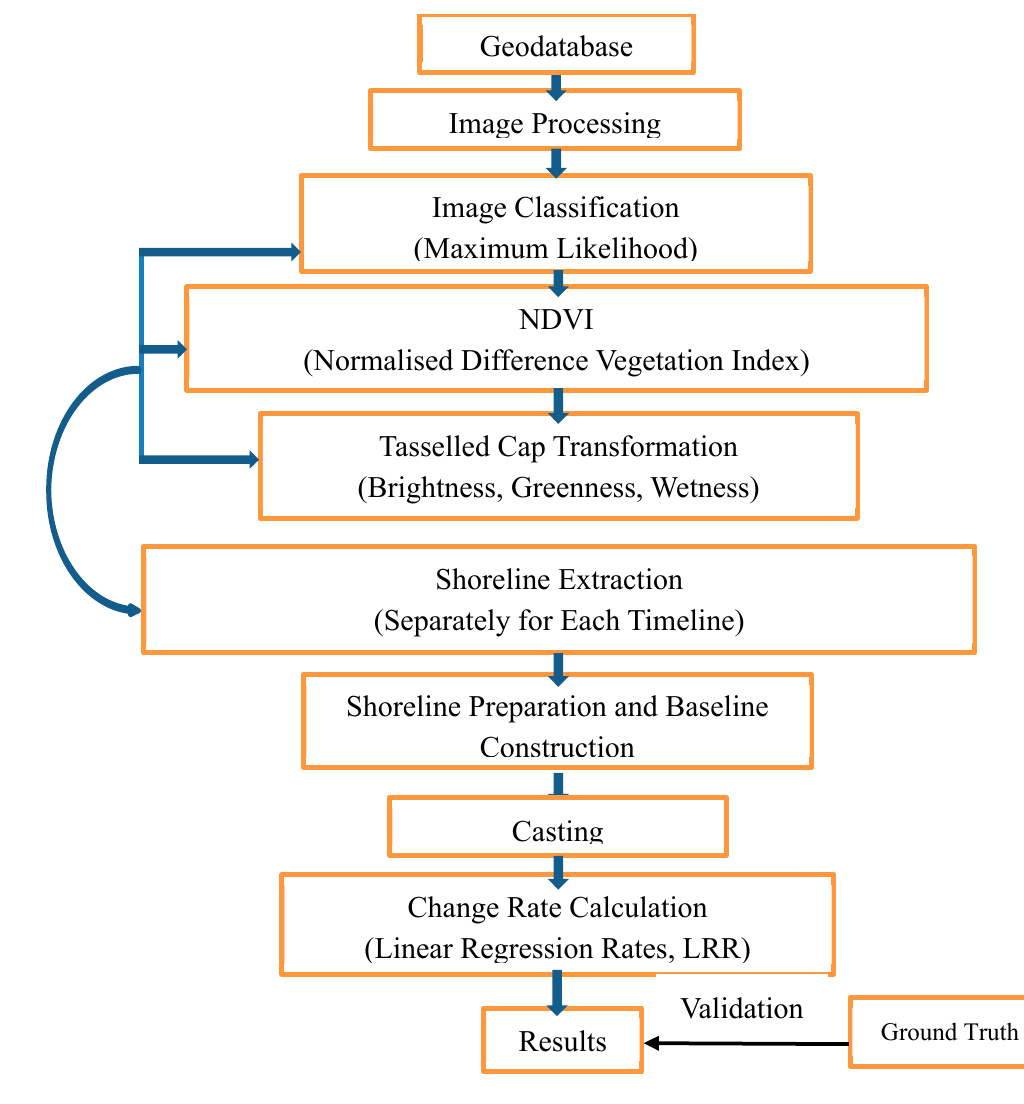
Figure 5. Flowchart of the methodology.